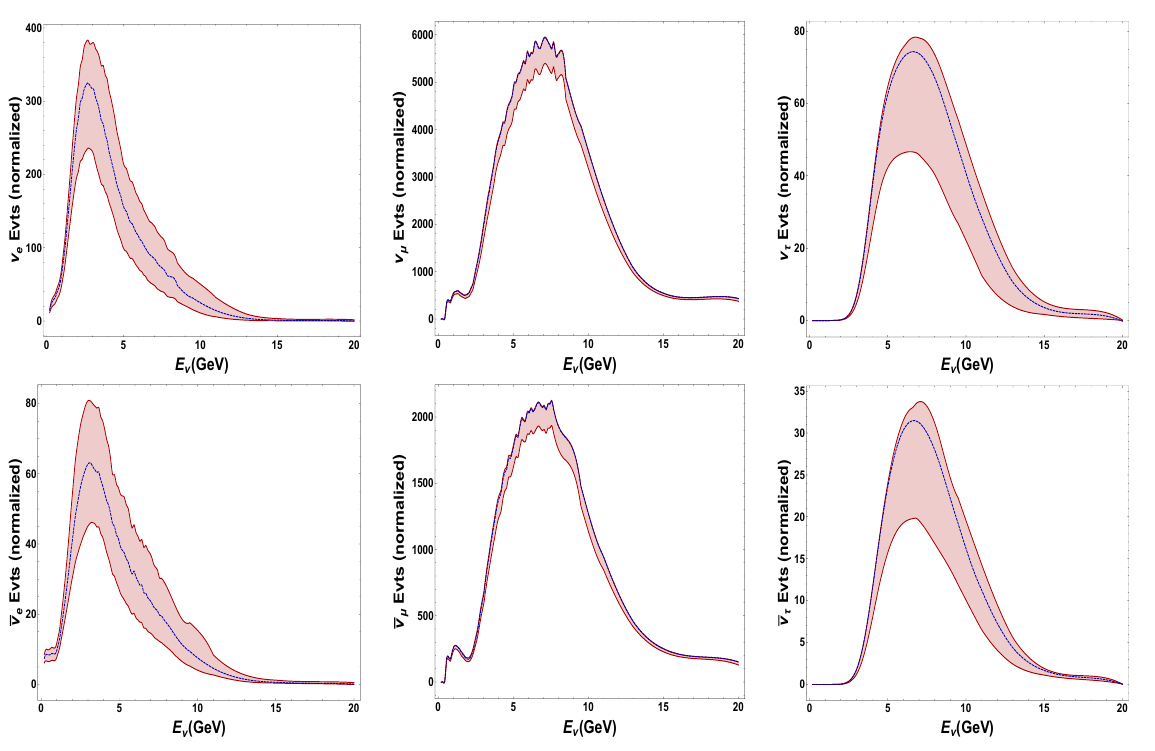
Figure 4. Same as Figure 2 but for the 3 + 1 neutrino mass